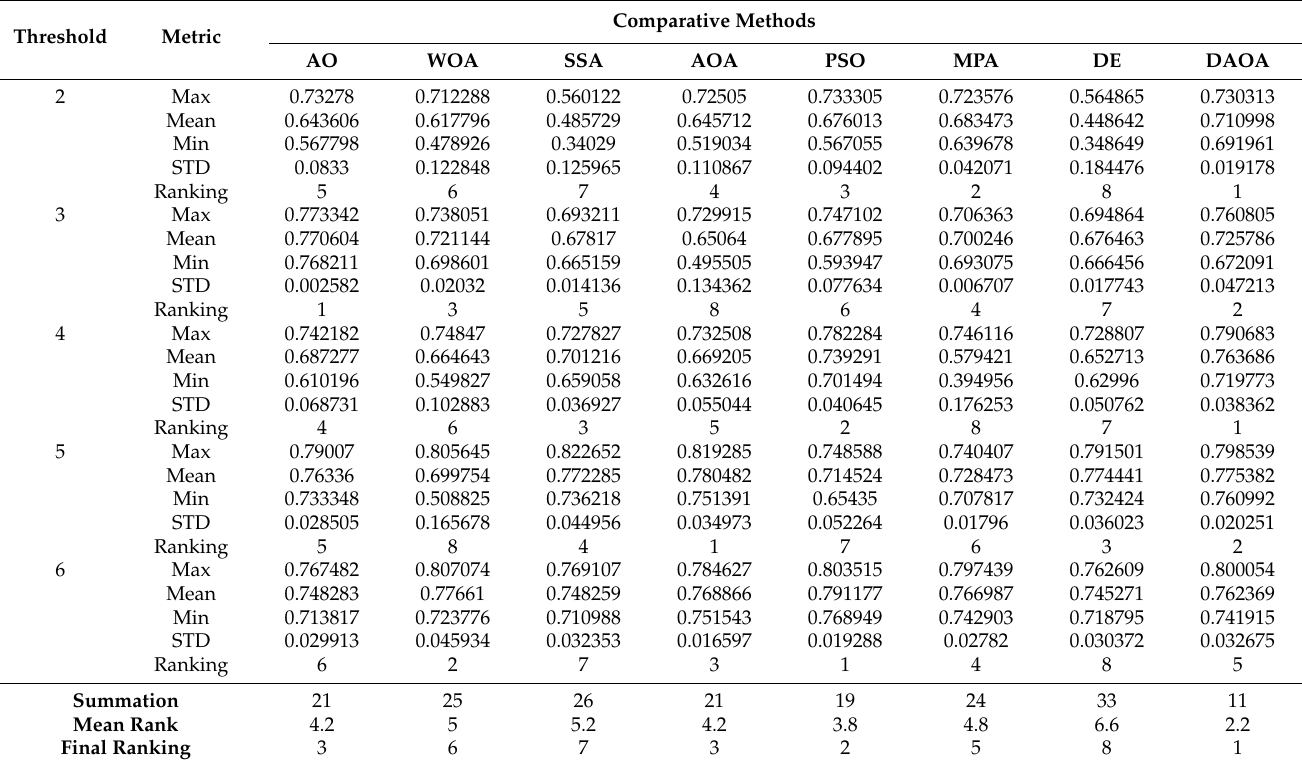
Table 15. The SSIM results of the test case